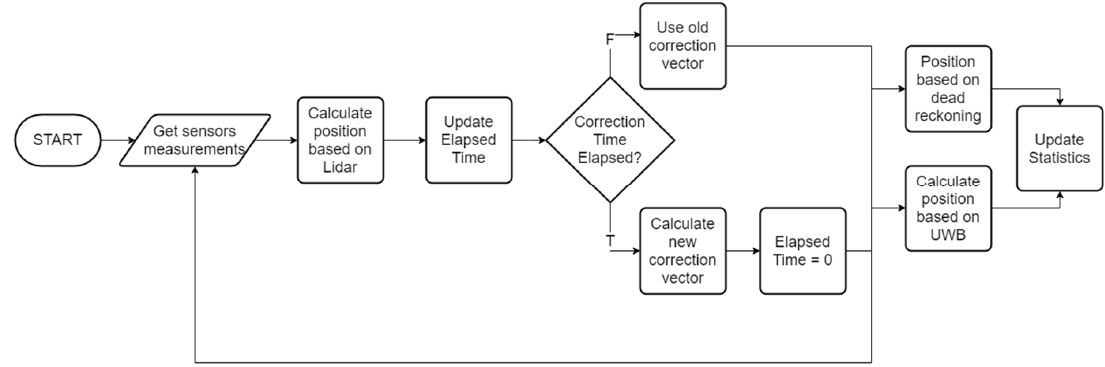
Figure 10. Block diagram of data flow in the prepared algorithm.